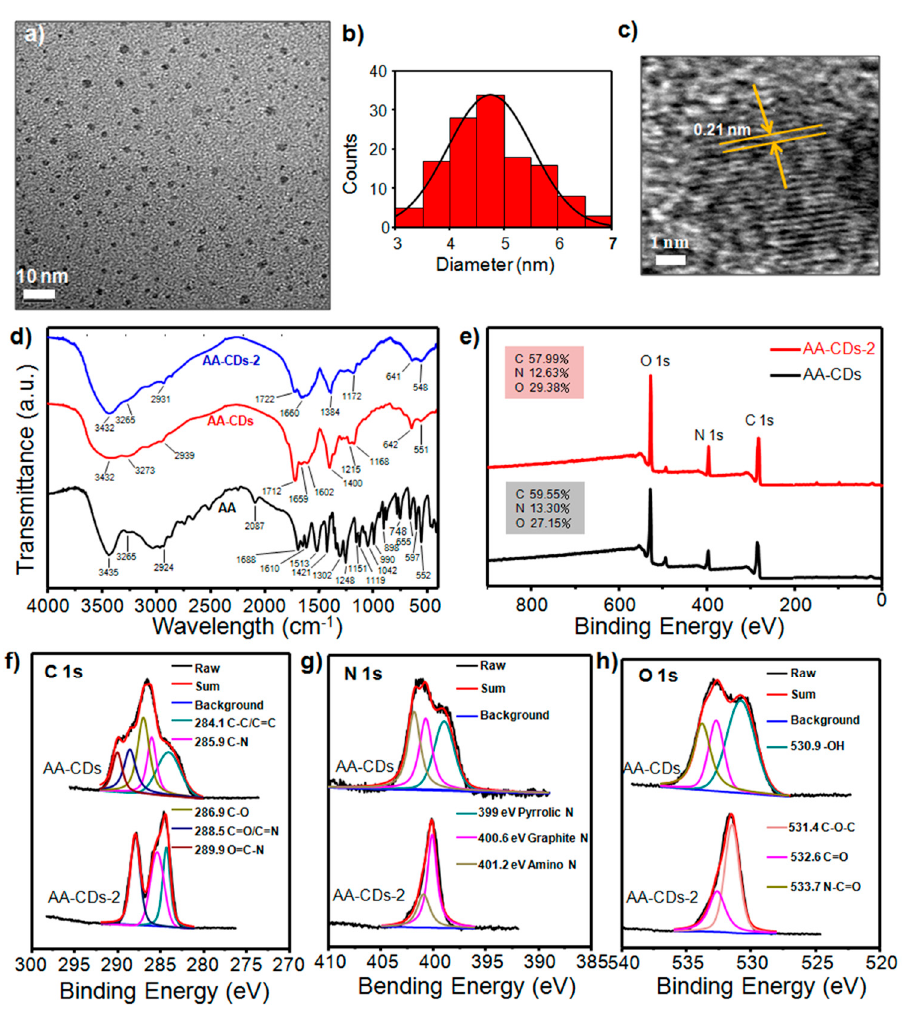
Figure 3. ( a ) Transmission electron microscopy (TEM) image, ( b ) the size histogram and ( c ) the high resolution TEM image of AA-CDs. ( d ) FT-IR spectra of L-aspartic acid (AA), AA-CDs and AA-CDs-2. ( e )X-ray photoelectron spectroscopy (XPS) spectra of AA-CDs and AA-CDs-2. ( f – h ) High-resolution XPS and corresponding fitting results for the C 1s ( f ), N 1s ( g ), O 1s ( h ), spectra of AA-CDs and AA- CDs-2.